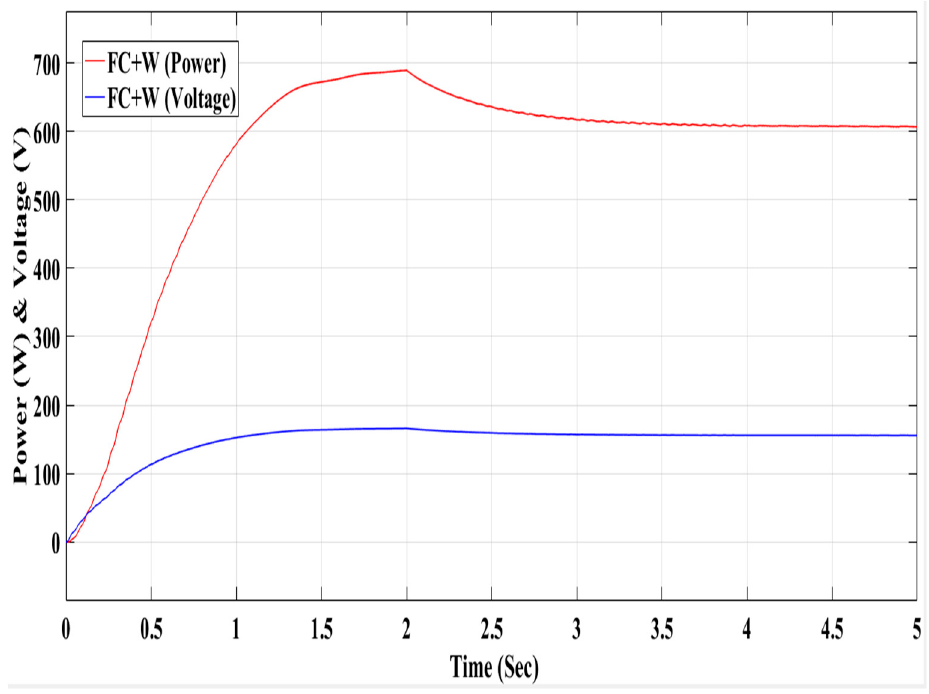
Figure 29. Power and voltage characteristics of the FC–W model using a fuzzy logic controller.